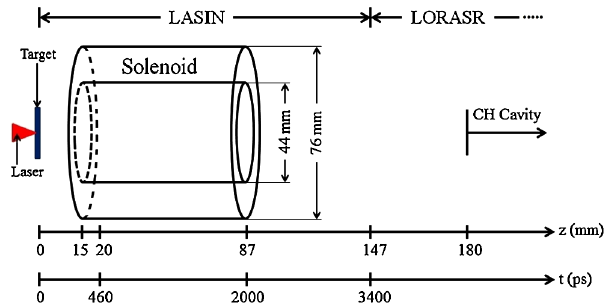
FIG. 2. Schematic view of the laser target, the focusing sole- noid, and the drift to the rf linac. The longitudinal axis is marked in mm and in ps time of flight for a 10 MeV on axis proton. Additionally, the range of LASIN and LORASR code based simu- lations are